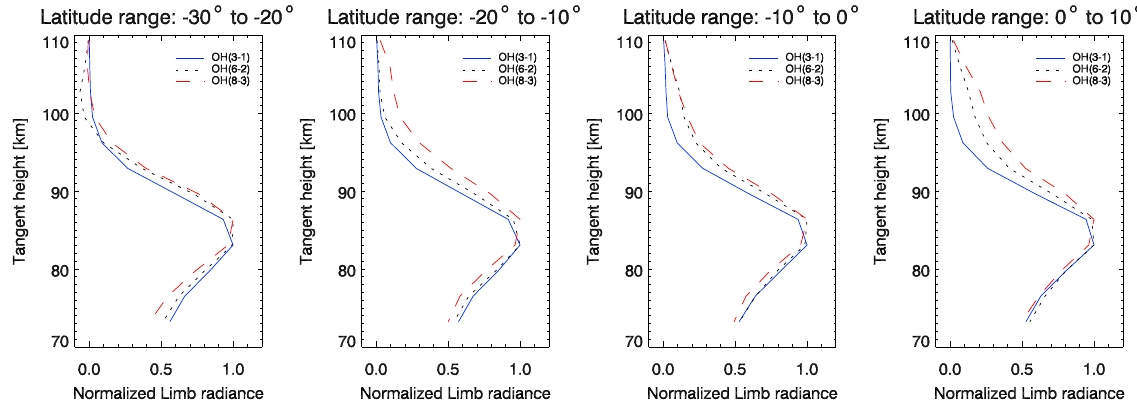
Fig. 4. Normalized monthly and zonally averaged limb-radiance profiles for the OH(3-1), OH(6-2) and the OH(8-3) band and the same latitude bins as in Fig. 2. The profiles are normalized with respect to the peak values for easier comparison. The altitude shifts between the different bands are already visible in the un-inverted limb-radiance